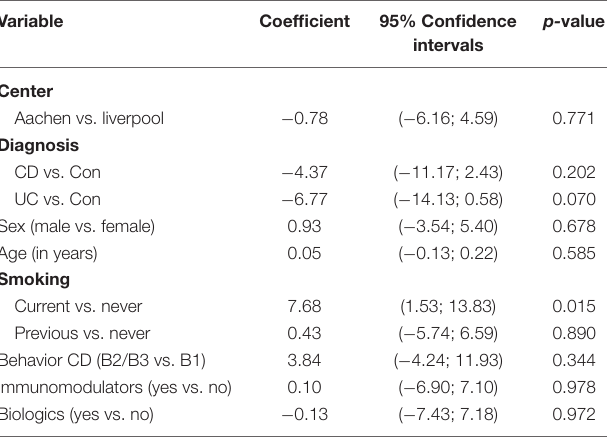
TABLE 2 | Demographic characteristics and associations with the Area under the curve (AUC) of the NF- κ B-regulated luciferase activity.